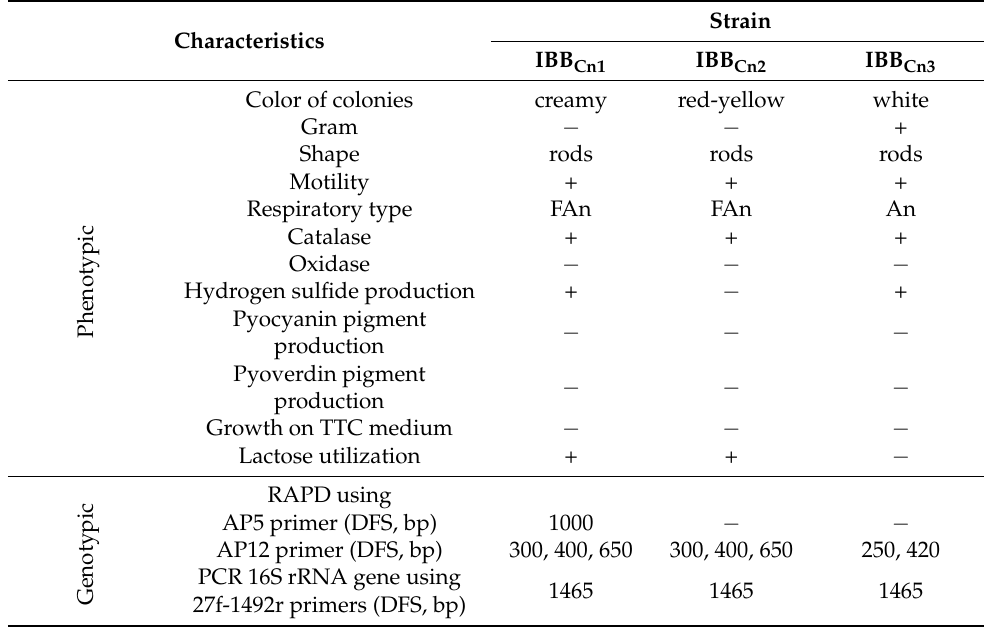
Table 1. Bacteria identification through phenotypic and genotypic